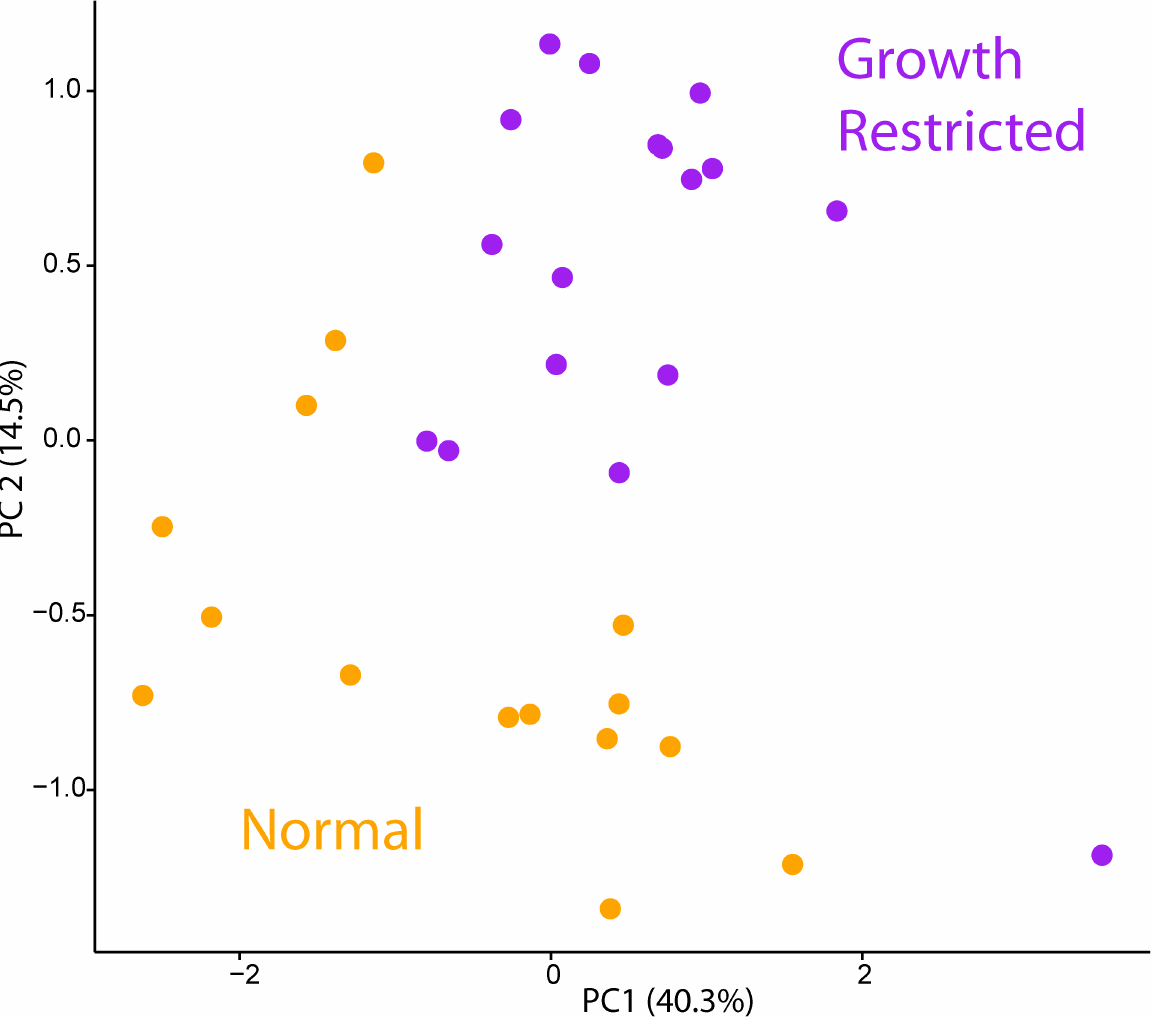
Fig 5. Principal component analysis of hepatic metabolites. Principal component analysisof hepatic metabolitevariables from rat pups at PD20 from either normal(orange) or growth restricted (purple)group. PC1 explains40.3% of the variation, whereasPC2